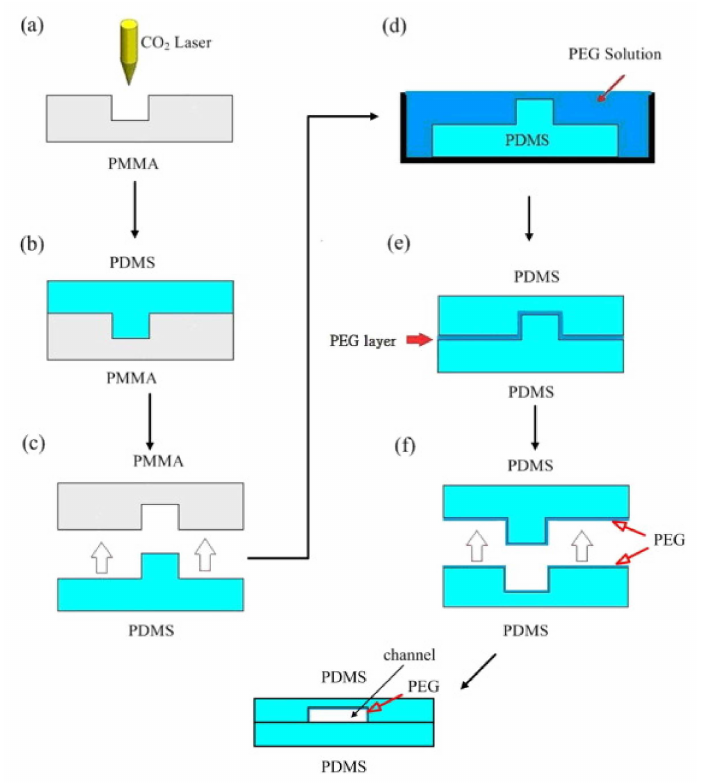
Figure 9. Scheme of fabricating the PDMS microfluidic chip includes: ( a ) the CO 2 laser ablation, ( b , c ) the first-step casting of PDMS, ( d ) surface modification, and ( e , f ) the second-step casting.